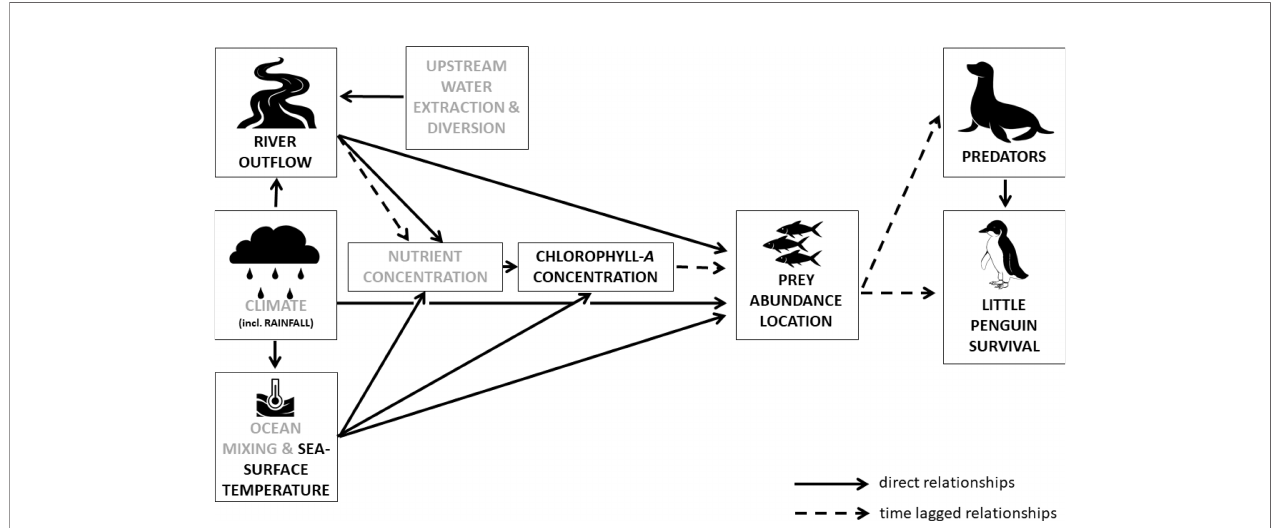
FIGURE 2 | Conceptual model detailing the relationships between the environmental variables included our study (rainfall, sea surface temperatures, and chlorophyll- a concentrations), food availability (prey abundance and location), little penguin survival, and their predators (long-nosed fur seals). Straight arrows represent direct relationships, while dashed arrows represent time lagged relationships. We also present in grey other variables (upstream water extraction and diversion, other climate variables, ocean mixing processes and nutrient concentration) that were not included in our models but affect food availability and environmental